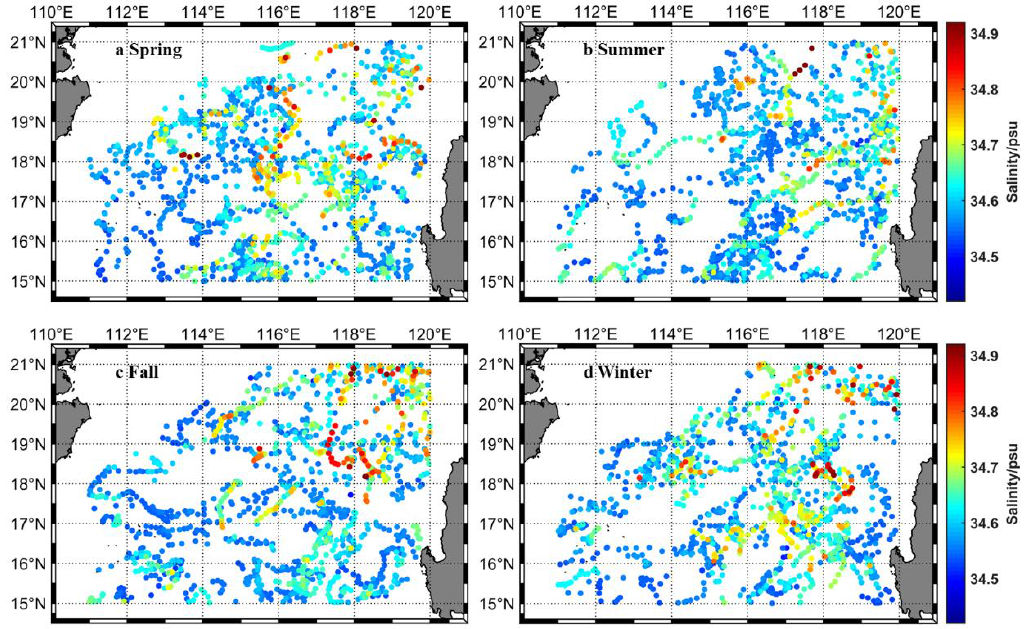
Figure 5. Seasonal variation of the salinity (psu) in the salinity-maximum layer.